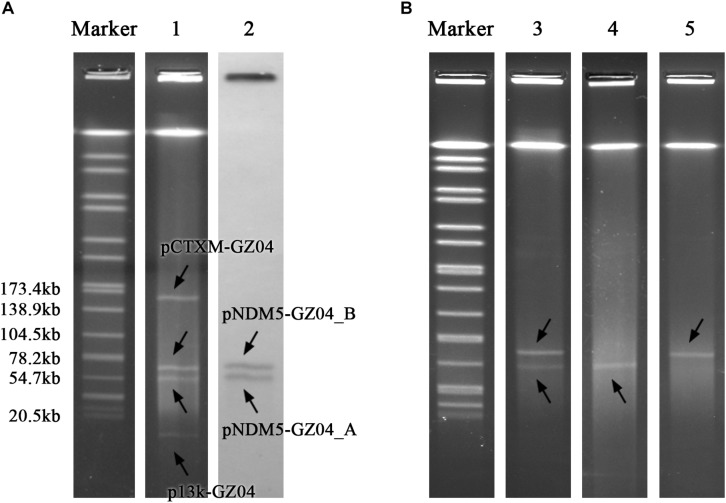
(A) S1-PFGE pattern for strain GZ04-0086 and southern blotting for the blaNDM–5 gene. (B) S1-PFGE pattern for E. coli J53 transconjugants. Lanes: Marker, Salmonella serotype Braenderup strain H9812 as a reference size standard; 1, PFGE result for S1-digested plasmid DNA of strain GZ04-0086; 2, southern blot hybridization with the probe specific to blaNDM–5; 3, 4, and 5, PFGE patterns for S1-digested plasmid DNA of E. coli transconjugants J53-AB, J53-A, and J53-B, respectively.